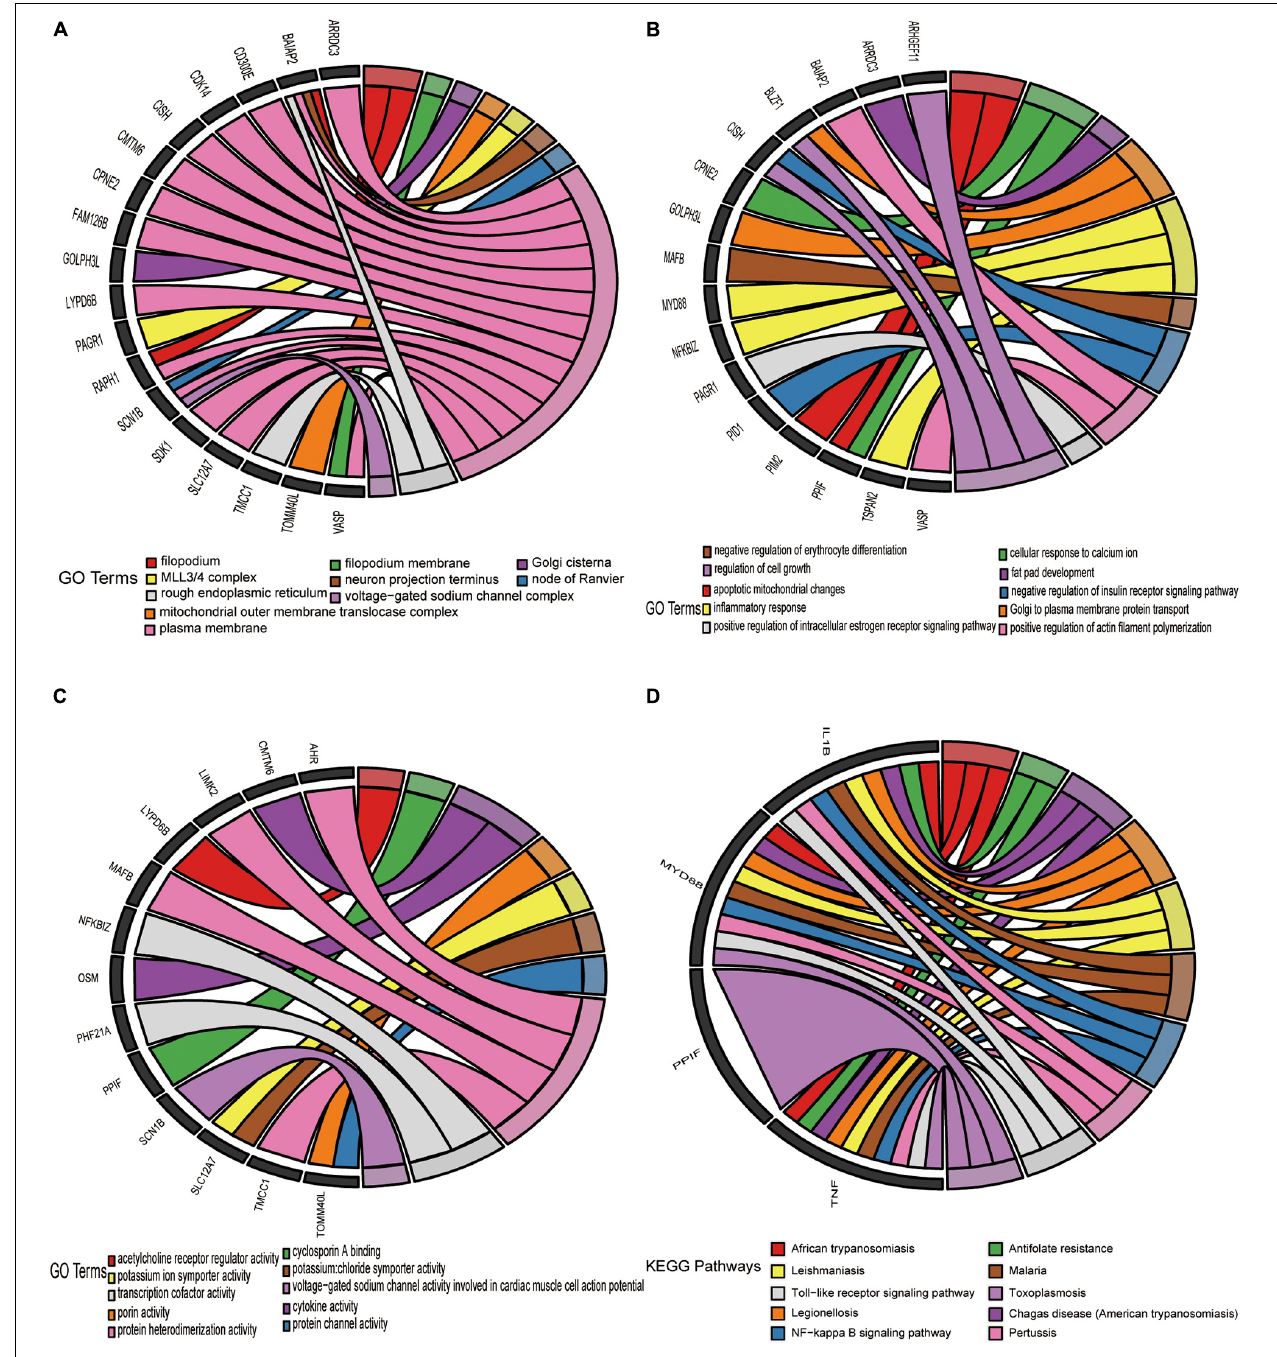
FIGURE 6 | Enrichment analysis of 52 upregulated target DE-mRNAs. Chord plots was used to visualize the enrichment analysis of these DE-mRNAs. (A) GO item cellular CC analysis. (B) GO item Bp analysis. (C) GO item MF analysis. (D) KEGG pathway analysis. The thresholds were a | log2FC| ≥ 0.58 and P -value ≤ 0.05.